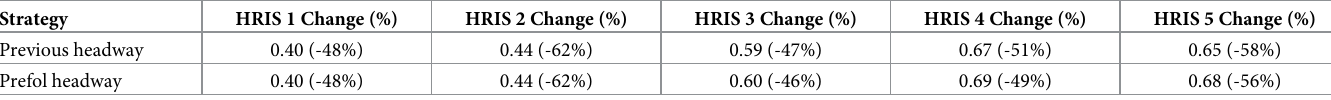
Table 15. Effect of holding strategies on headway regularity index.